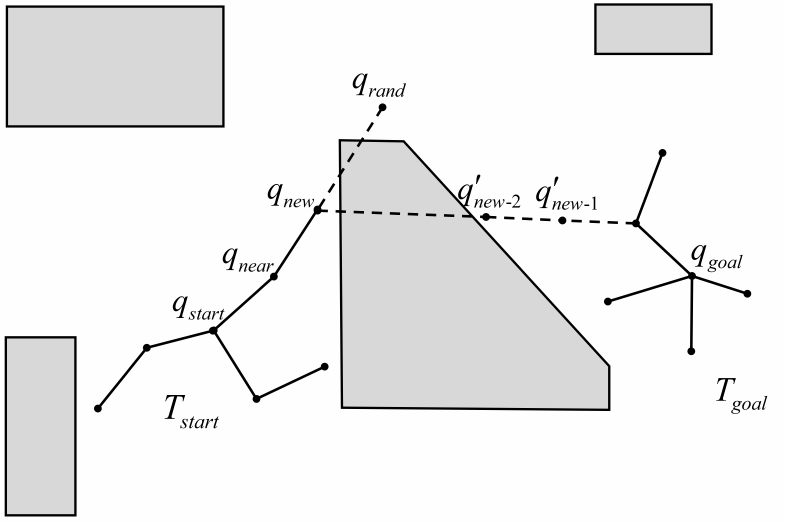
Figure 4. Node expansion of RRT-Connect